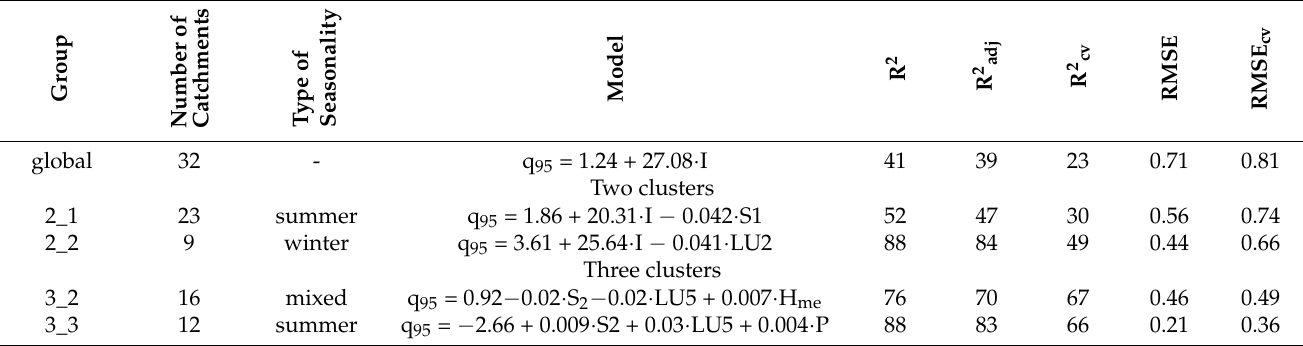
Table 2. Regional regression model based on K-mean